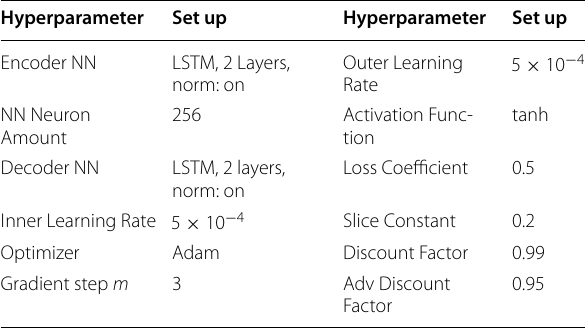
Table 5 MLR-LC-DRLO Hyperparameter set up